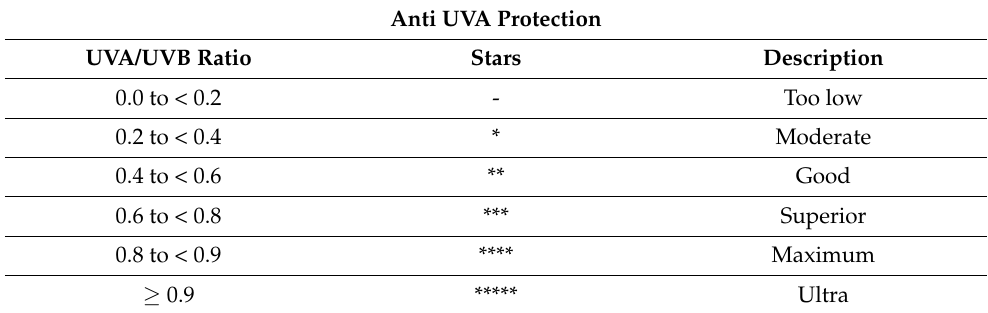
Table 5. Boot’s Star rating